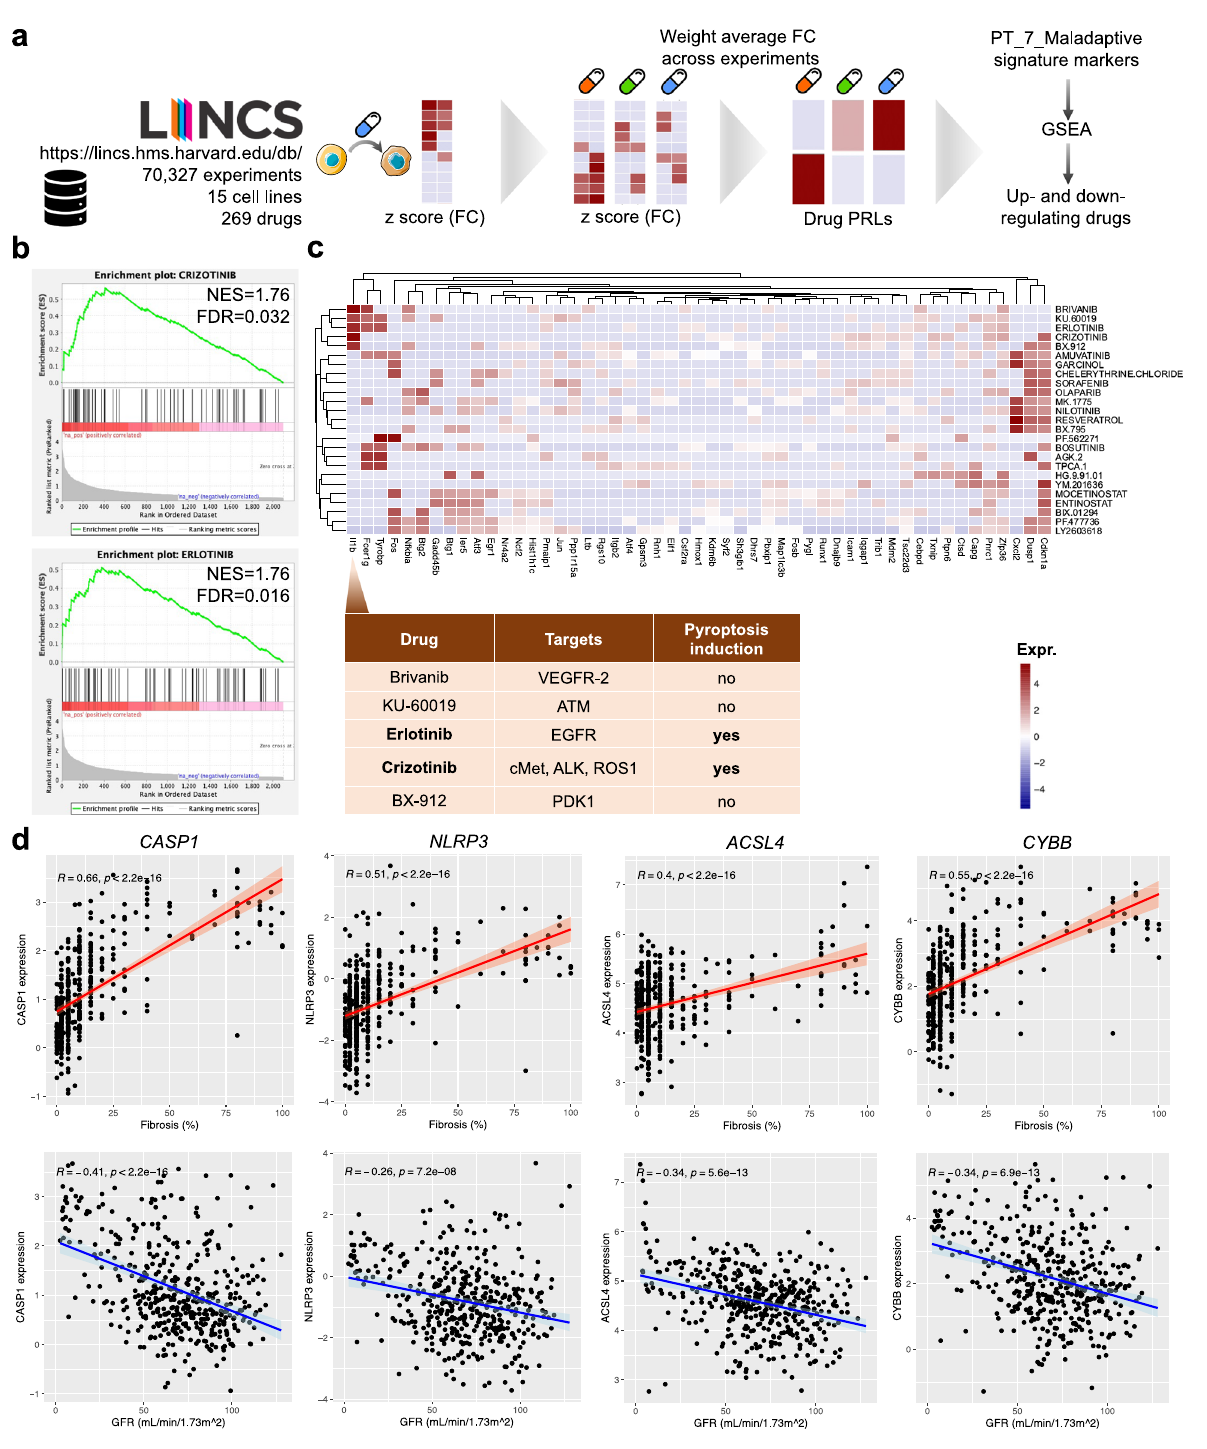
Fig. 8 Druggability screen identi fi es pyroptosis and ferroptosis as key driver pathways for maladaptive repair. a Experimental setup: Identifying candidate molecules for drug: Gene expression values were calculated from experiments in the LINCS database and used to select drugs that would up- or downregulate the genes identi fi ed as Maladaptive PT markers. b Gene set enrichment analysis (GSEA) plots of top 2 drug response patterns overlapping with pre-ranked maladaptive DEGs ( “ Methods ” ). c Corresponding leading edge analysis heatmap visualizing expression of core genes enriched in the respective top 24 drug response patterns overlapping with pre-ranked maladaptive DEGs. Il1b was among the genes upregulated most frequently and the drugs eliciting Il1b upregulation are listed in the corresponding table along with their target and whether they induce pyroptosis or not. d Correlation of pyroptosis ( CASP1, NLRP3 ) and ferroptosis ( ACSL4, CYBB ) marker gene expression in microdissected human kidney tubules with fi brosis (top row) and eGFR (bottom row); error bands represent 95% con fi dence